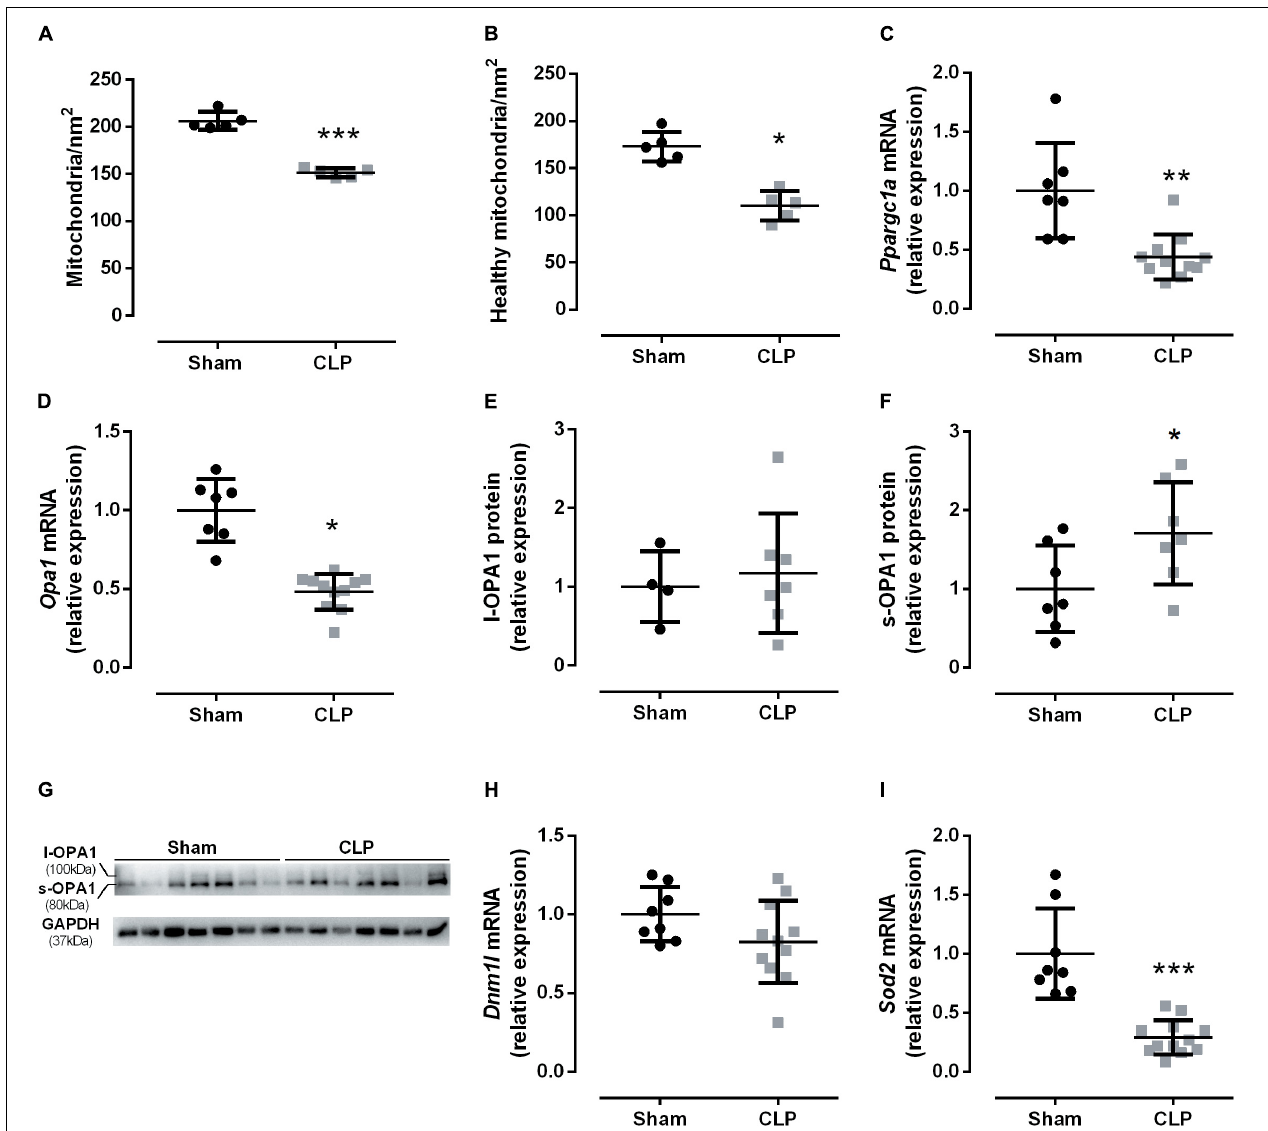
FIGURE 5 | Sepsis disrupted diaphragm mitochondrial dynamics. Quantification of mitochondrial total (A) and healthy (B) quantity. The mitochondrial quality was assessed by the following factors: disrupting the mitochondrial membranes (injured mitochondria), the mitochondrial morphology: the preservation of the mitochondrial cristae, and the matrix electron density (healthy mitochondria), intact external membranes (healthy mitochondria), intact cristae and continuous folds (healthy mitochondria), and matrix electron density (injure mitochondria present low electron-dense matrix). mRNA expression of Ppargc1a (encodes PGC1 α ; C ); Opa1 (fusion marker; D ); relative protein expression of the functional l-OPA1, 100 kDa isoform (E) , cleaved isoform s-OPA1, 80 kDa (F) , OPA1 and GAPDH (loading control) representative Western blot gels (G) . mRNA expression of Dnm1l (fission marker; H ) and Sod2 (encodes mitochondrial superoxide dismutase – SOD2; I ). Black dots represent sham animals caused by surgical stress, and gray squares represent CLP – cecal ligation puncture technique. Values are expressed as mean ± SD, * p < 0.05, ** p < 0.005, and *** p = 0.0002 compared with sham